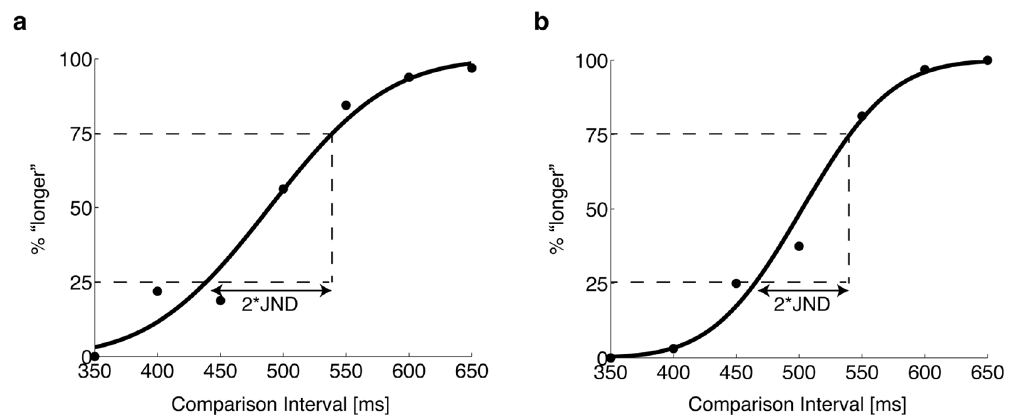
Fig 5. Psychometric functions of visual (a) and auditory (b) intervals for a typical subject. The probabilities at which the subject judged that the comparison (350 – 650 ms) was longer than the standard (500 ms) were plotted, and fitted to the cumulative normal distribution function. The discrimination sensitivity was defined as the Weber fraction, the ratio of the just noticeable difference (JND) to the standard interval.